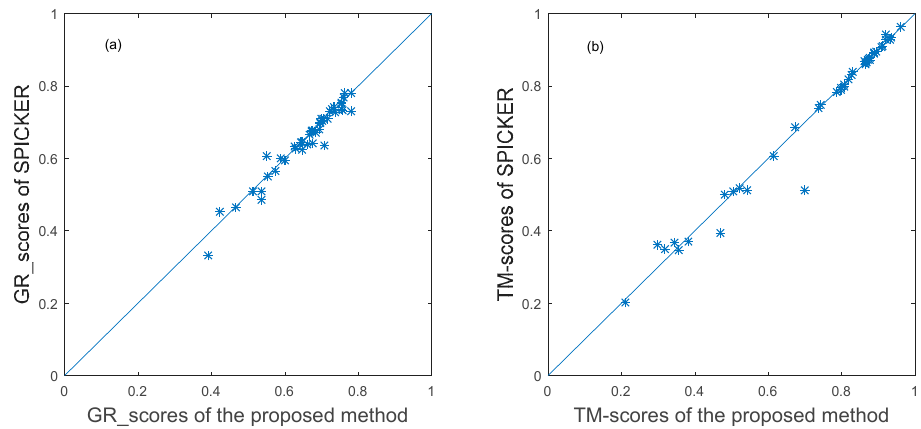
Figure 4: The plot of GR_scores and TM-scores produced by two methods for datasets from CASP10. 257 Figure 4. The plot of GR_scores and TM-scores produced by two methods for datasets from The details of the comparison can also be found in Table 1, in which the first column is the ID of 258 the target protein, the second column and the third column are the GR_scores of the selected 259 near-native models by the proposed method and the SPICKER method, the fourth column and the 260 fifth column are the TM-scores of the selected near-native model by the proposed method and the 261 SPICKER method. All the scores were computed between the selected near-native model and the 262 corresponding native structure. 263